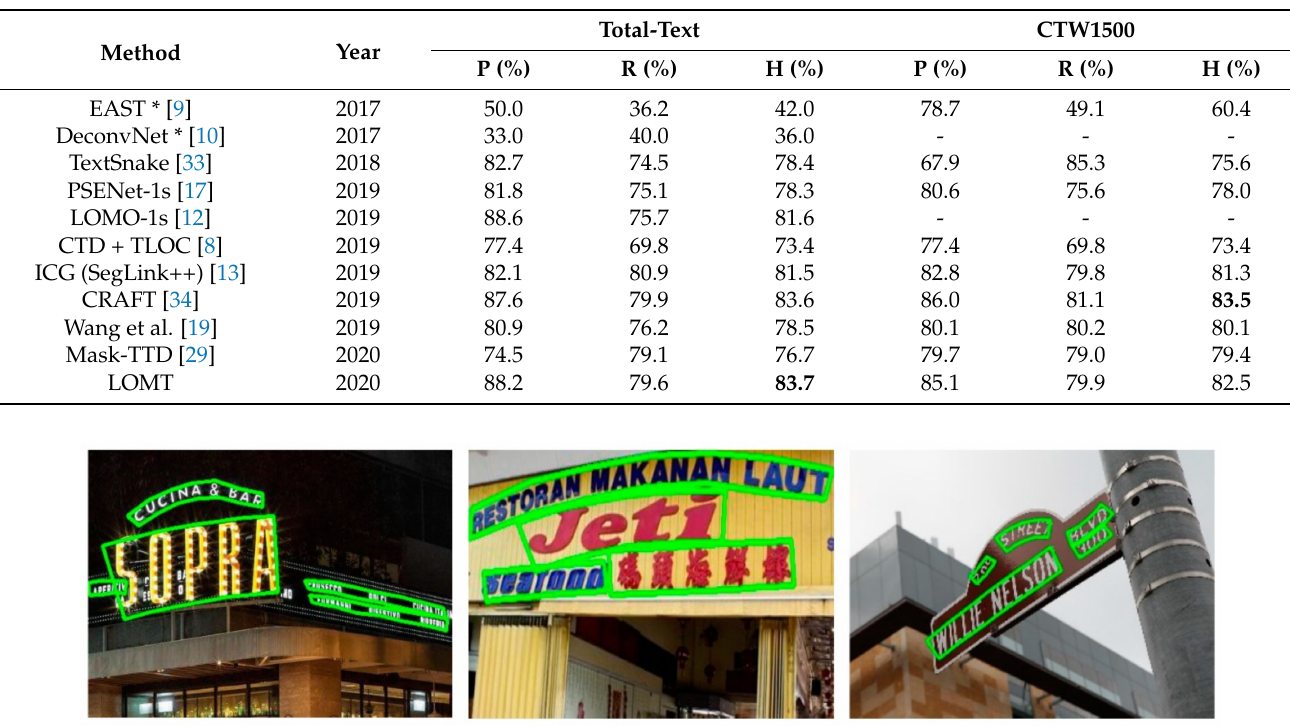
Table 2. Results on curved text datasets Total-Text and CTW1500. The best H score is highlighted in bold and * denotes the results based on multiscale tests.